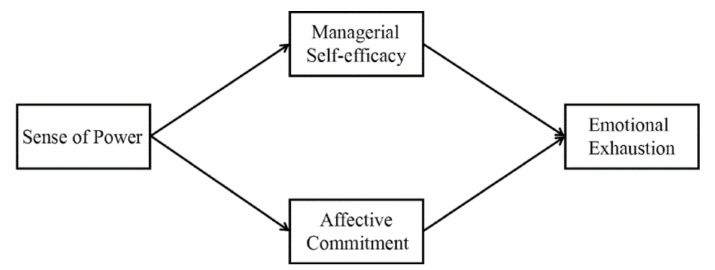
Figure 1. The proposed conceptual